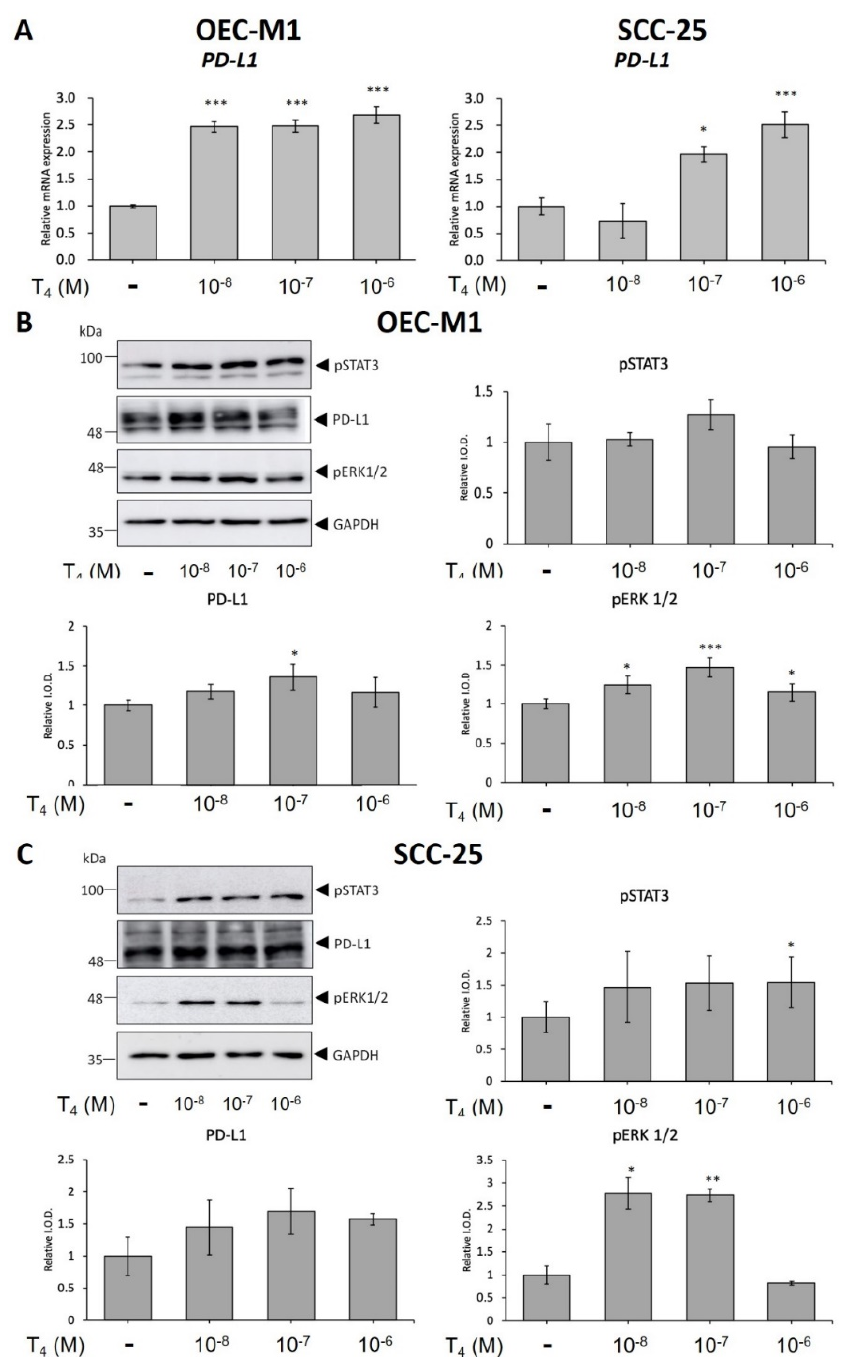
Figure 1. Thyroid hormone induces abundances of PD-L1 in human oral cancer cells. OEC-M1 cells and SCC-25 cells were treated with different concentrations of thyroid hormone (T 4 , 10 -8 to 10 -6 M) for 24 h. ( A ) Thyroid hormone-induced PD-L1 expression in both oral cancer cell. ( B ) OEC-M1 cells and ( C ) SCC-25 cells were treated with different concentrations of T 4 for 24 h. Cells were harvested. Total protein was extracted and Western blot analyses of pSTAT3, pERK1/2, PD-L1 were performed in Data were presented as the mean ± SD. Results are from three independent studies ( n = 3). * p < 0.05, ** p < 0.01, *** p < 0.001, compared to the control. I.O.D., intensity of the optical